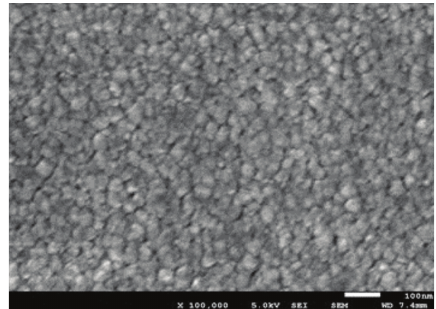
Figure 3: SEM image of an Mg 0.52 Zn 0.48 O thin film.